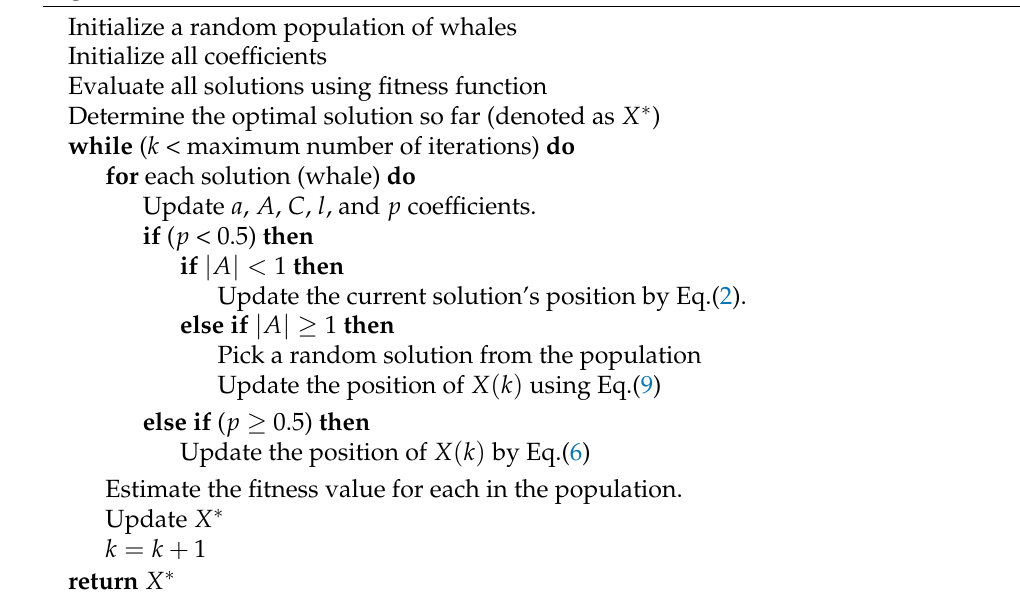
Algorithm 2 Pseudo-code of